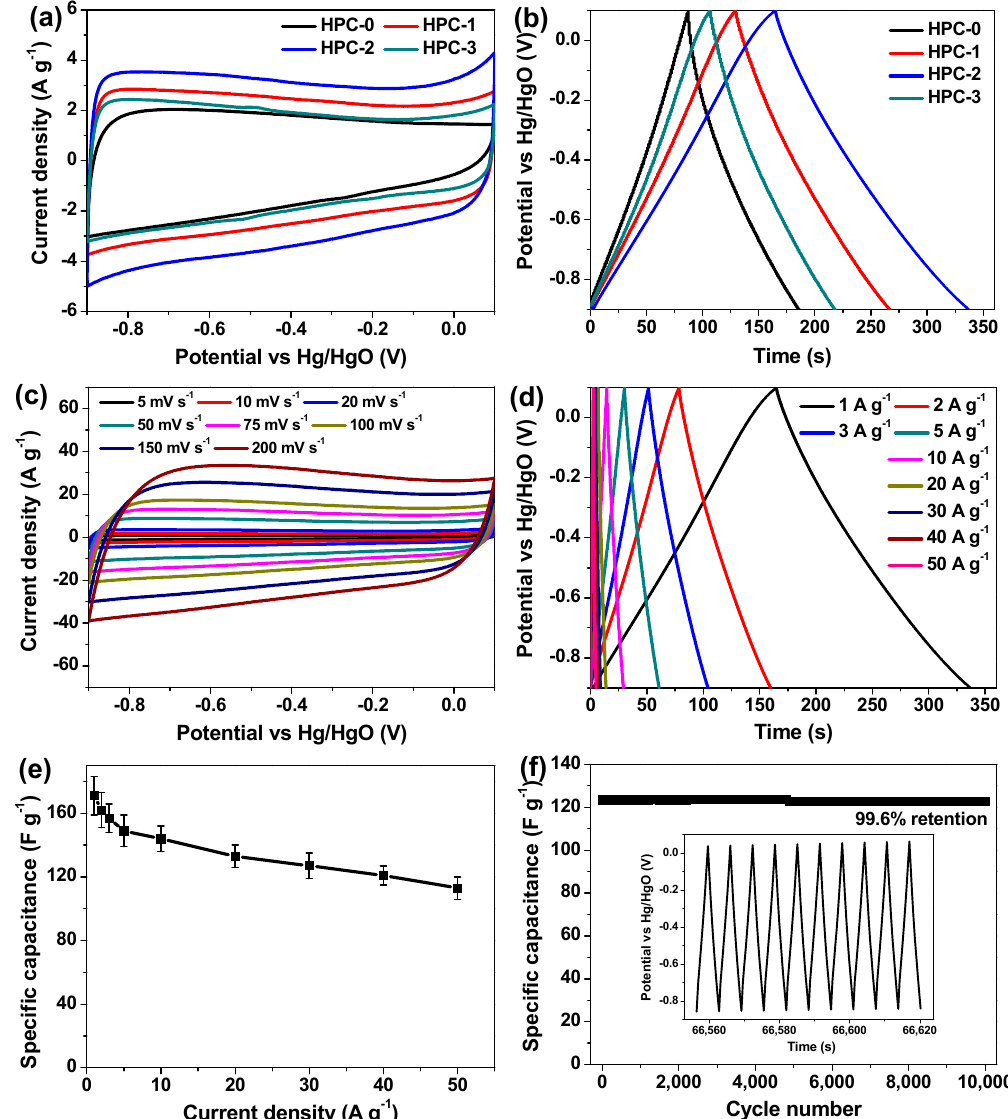
Figure 6. Electrochemical characterizations of the currently fabricated carbon electrodes measured in a three-electrode system. ( a ) CV curves of HPC-0, HPC-1, HPC-2, and HPC-3 electrodes acquired at the identical scan rate of 20 mV s − 1 ; ( b ) GCD curves of HPC-0, HPC-1, HPC-2, and HPC-3 electrodes obtained at the same current density of 1 A g − 1 ; ( c ) CV curves of HPC-2 electrode tested at varied sweep rates; ( d ) GCD curves of HPC-2 electrode tested at different current densities; ( e ) the relationship of specific capacitance of HPC-2 electrode versus current density; and ( f ) the cyclic performance of HPC-2 electrode for continuous charge/discharge at rather a high current density of 40 A g − 1 for up to 10,000 cycles; the inset shows the charge/discharge curve of such cycling test for the final 10